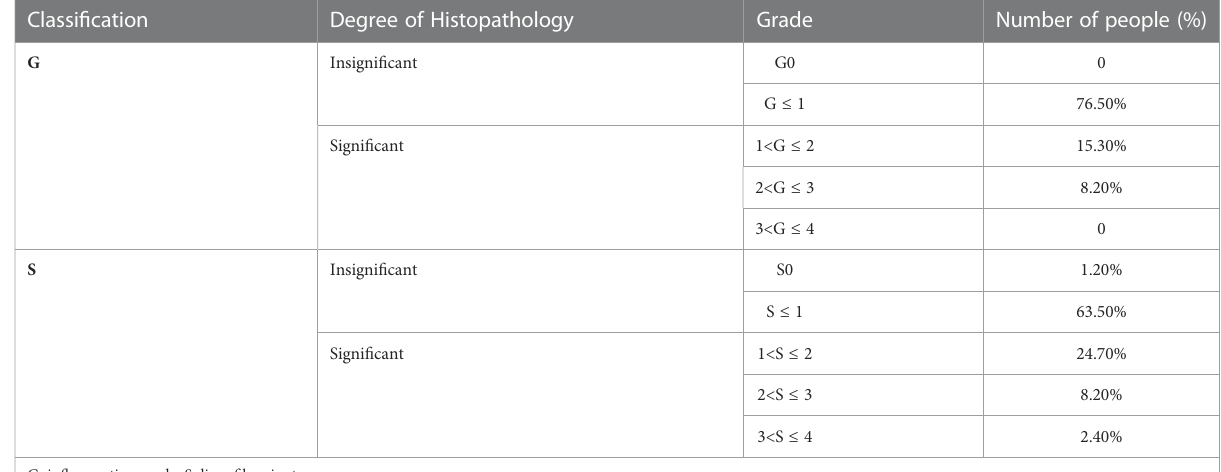
TABLE 2 Histopathological grade distribution table for liver biopsies of HBeAg-negative and HBV DNA-negative patients. Classi fi